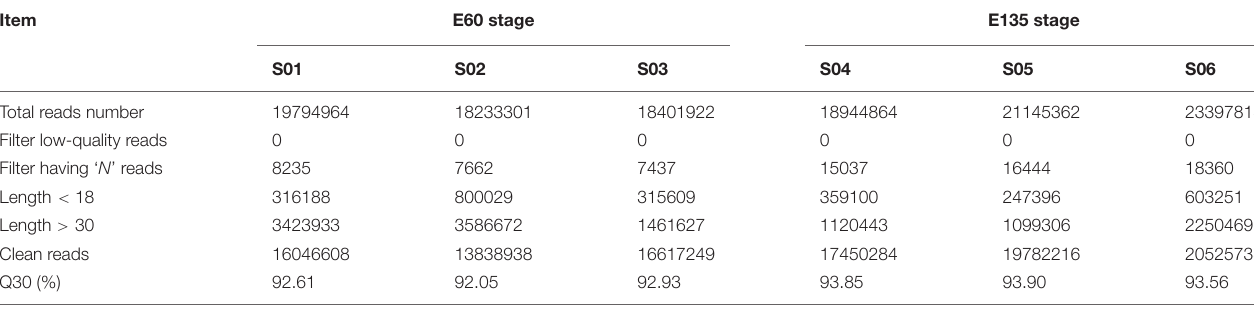
TABLE 1 | Summary of reads from raw data and clean reads for microRNAs (miRNAs) sequencing in goat